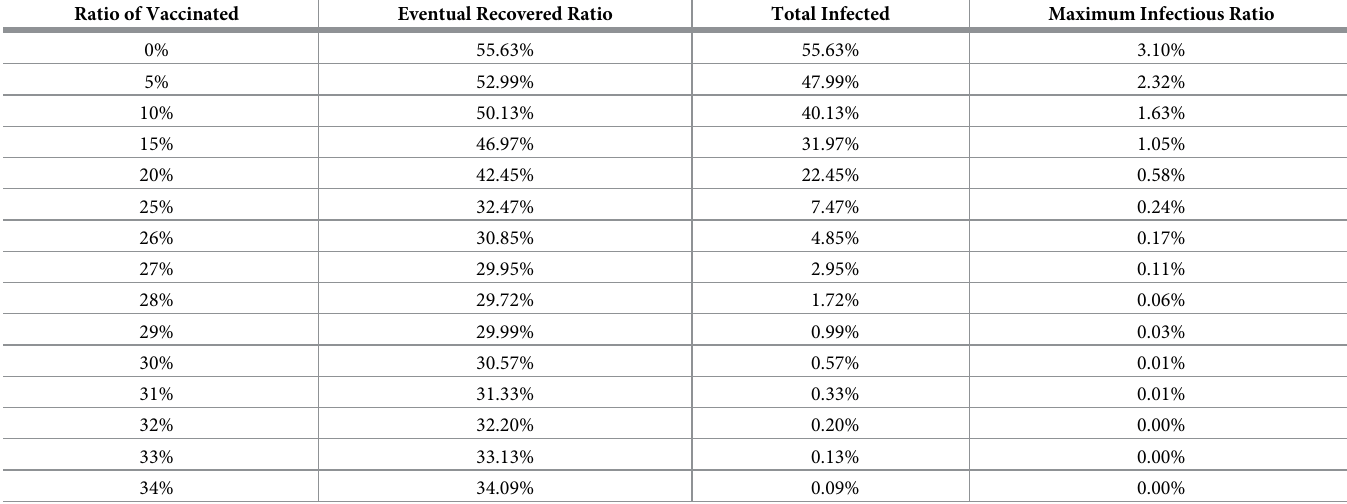
Table 3. How vaccinating different ratios of the population of Germany change the total and maximum Infectious ratios. It is assumed the population is under a con- tainment policy that keeps R 0 =